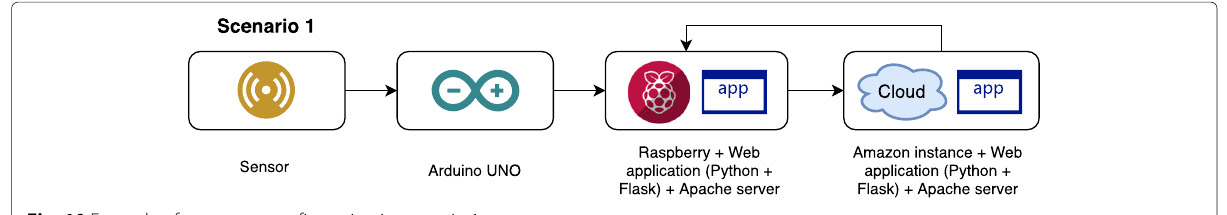
Fig. 10 Example of prototype configuration in scenario